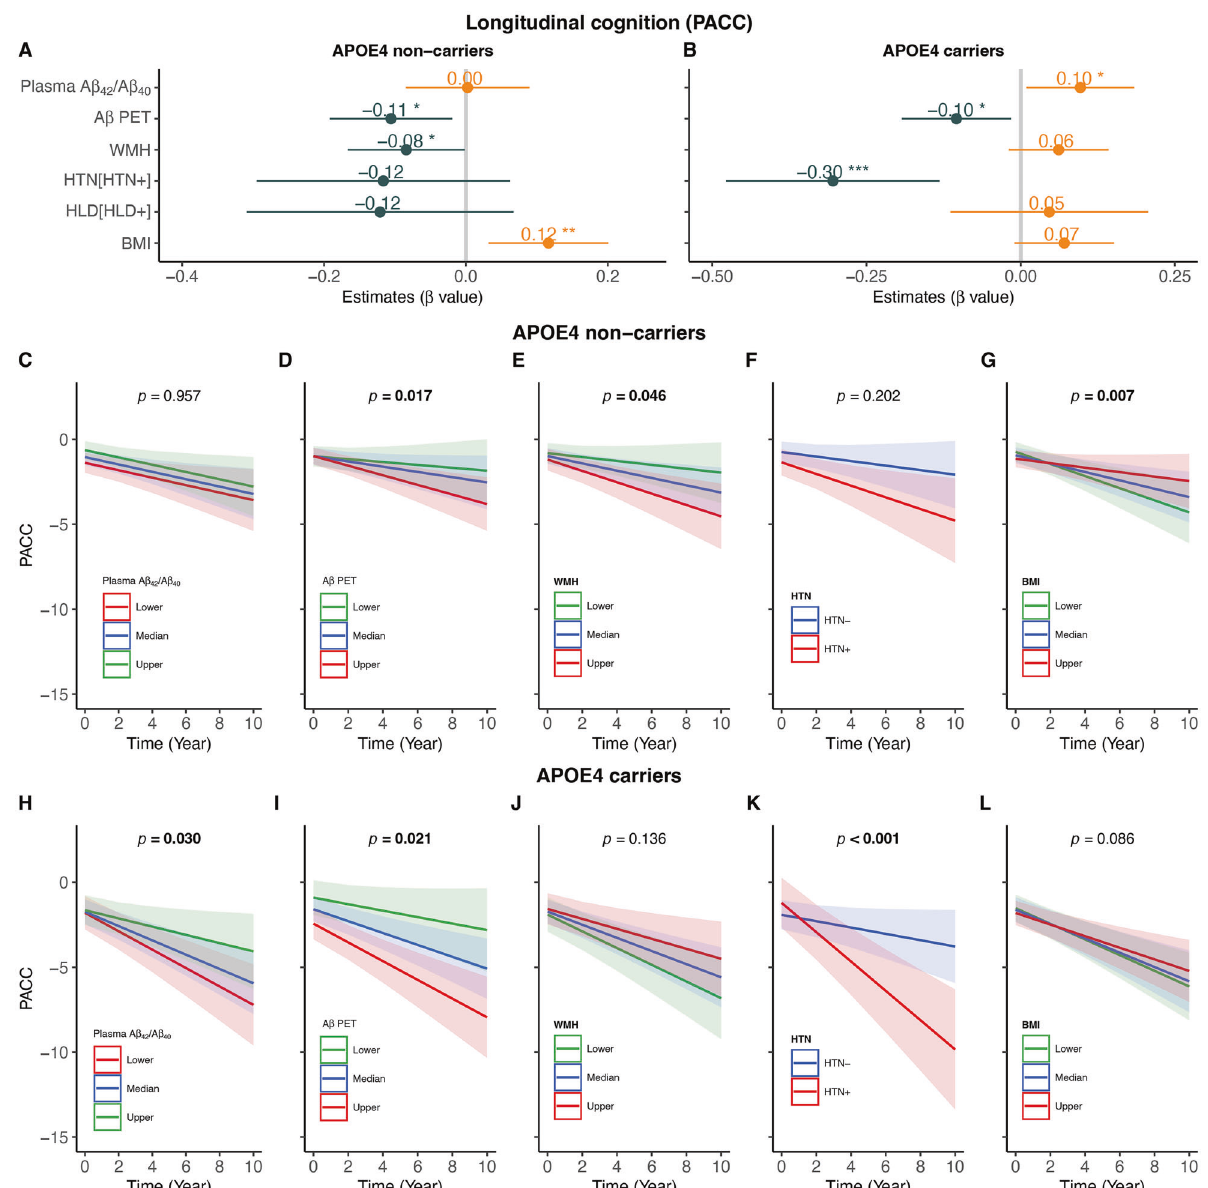
Fig. 4 Predictors of longitudinal cognitive decline. Associations of longitudinal PACC changes over time by baseline plasma A β 42 /A β 40 , A β PET, WMH, hypertension (HTN), Hyperlipidemia (HLD) and body mass index (BMI) in ( A ) APOE- ε 4 non-carriers and ( B ) APOE- ε 4 non-carriers. Prediction of longitudinal PACC changes over time by baseline plasma A β 42 /A β 40 , A β PET (FBP SUVR), WMH, HTN and BMI in APOE- ε 4 non- carriers ( C – G ) and carriers ( H – L ). Notes: APOE- ε 4 non-carriers (HTN − : n = 60, HTN + : n = 43), APOE- ε 4 carriers (HTN − : n = 44, HTN + : n = 18); lower, median and upper represent the value that cuts off the fi rst 25%, 50% and 75% of the data when it is sorted in ascending